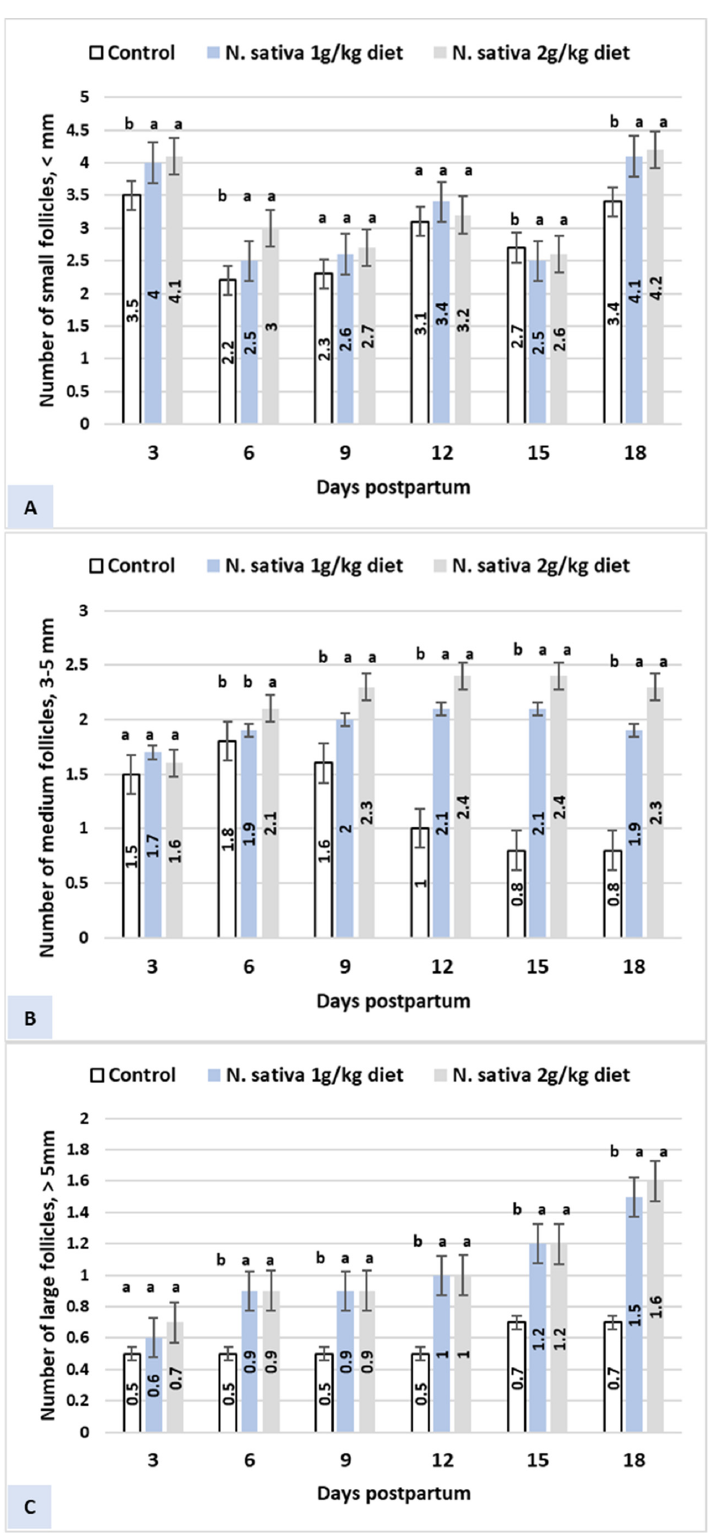
Figure 1. Effects of N. sativa (10.0 and 20 g/kg diet) on ovarian follicle development postpartum of Ardi goats. a, b Values with different superscripts between groups significantly differ at p < 0.05. ( A ) Number of small follicles < 3 mm; ( B ) Number of medium follicles 3–5 mm; ( C ) Number of large follicles > 5